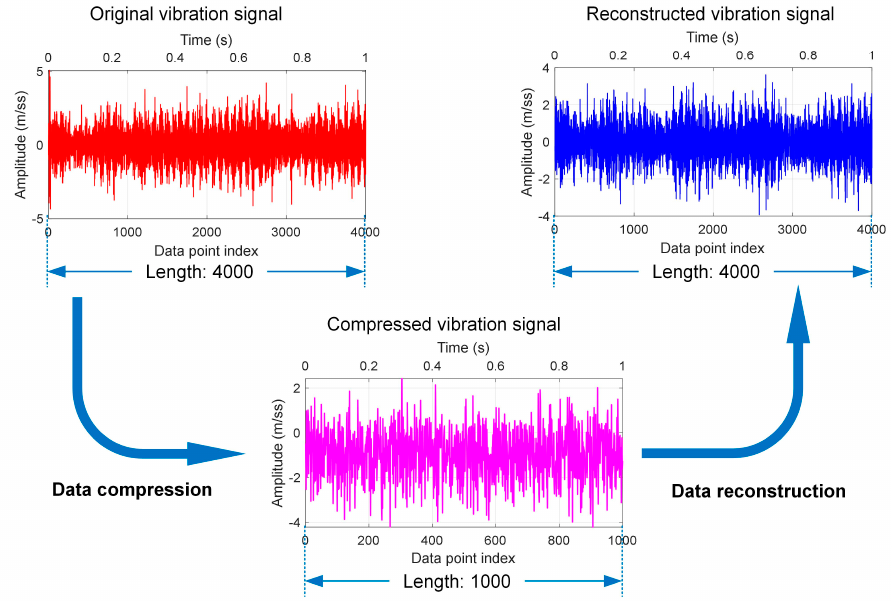
Figure 29. RPD: vibration signal reconstruction.